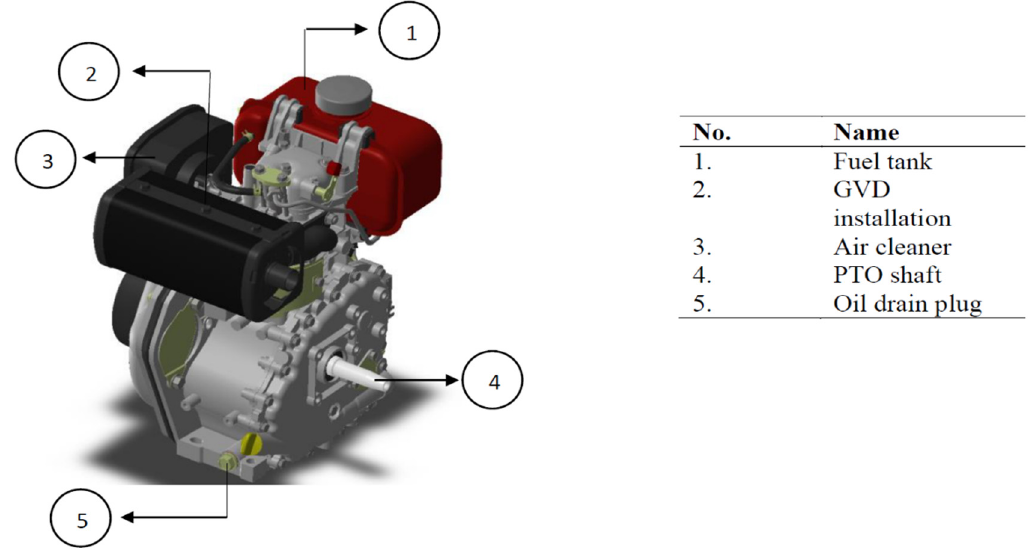
Figure 1. YANMAR L70AE CI generator diesel engine.